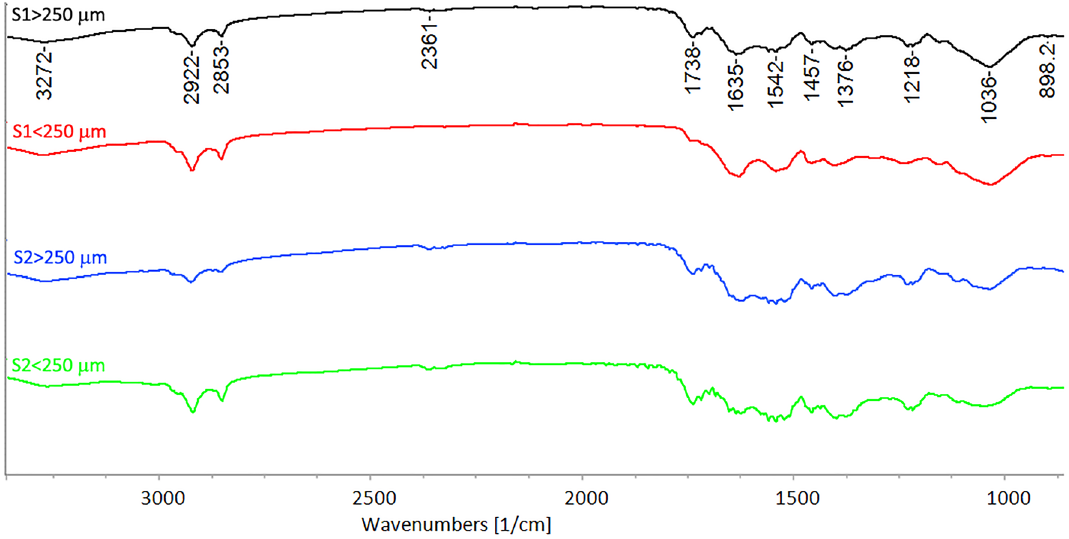
Figure 2. Normalized FT-IR transmittance spectra of the nitrogen-rich fractions.